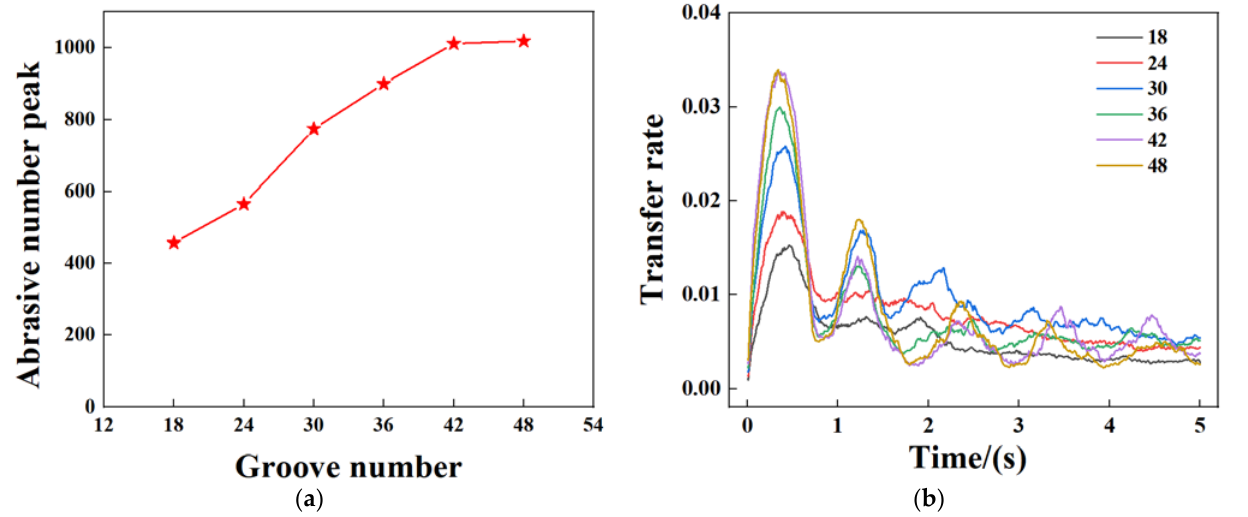
Figure 10. Variation curve of abrasive transfer rate under different groove numbers of 7 mm groove width retaining ring: ( a ) Abrasive number peak as a function of groove number, ( b ) abrasive transfer rate under different groove numbers.